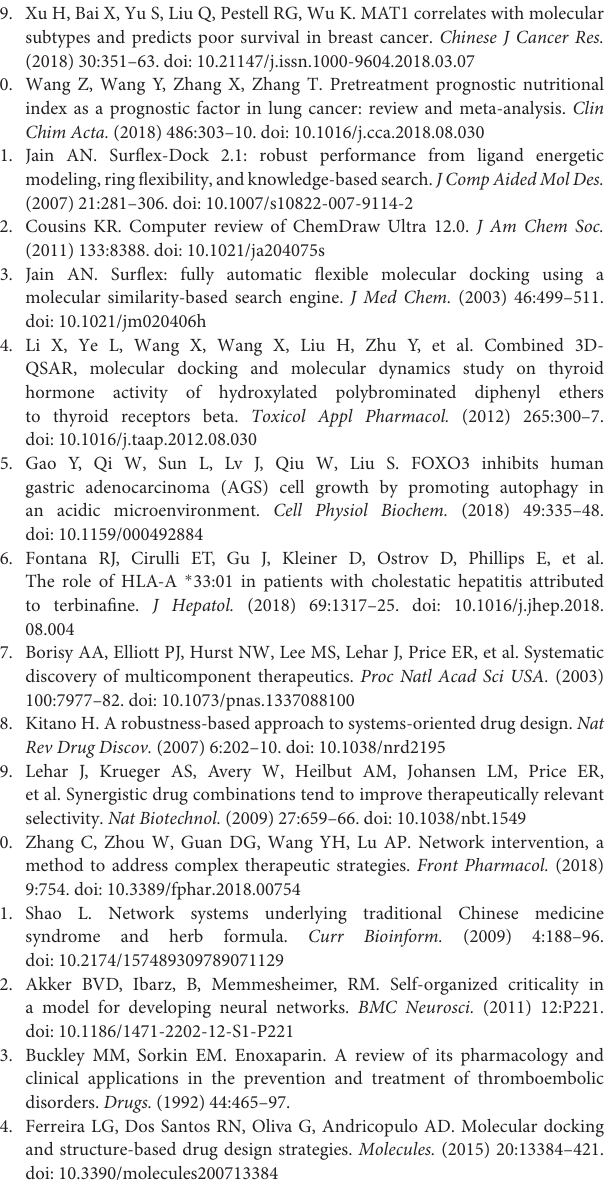
Figure S1 | CCNB1 and CDC6 act as downstream genes of P53 and regulate DNA biosynthesis pathway and cell cycle arrest